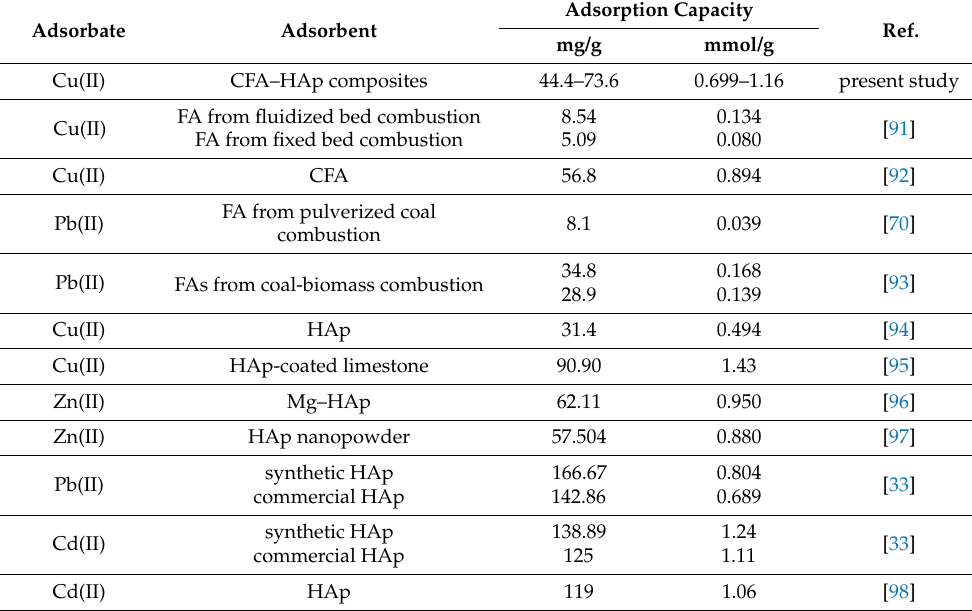
Table 7. Comparison of the adsorption capacity of CFA and HAp for heavy